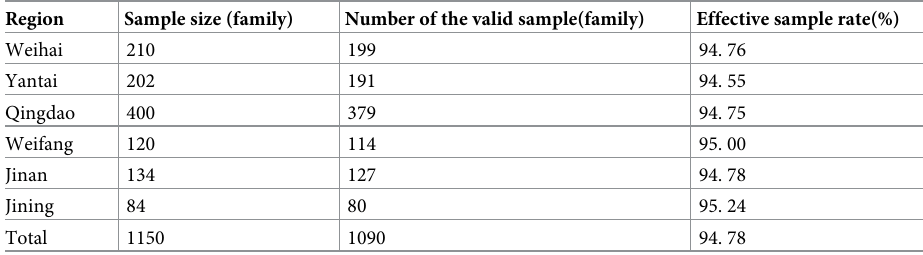
Table 1. Regional distribution of samples.